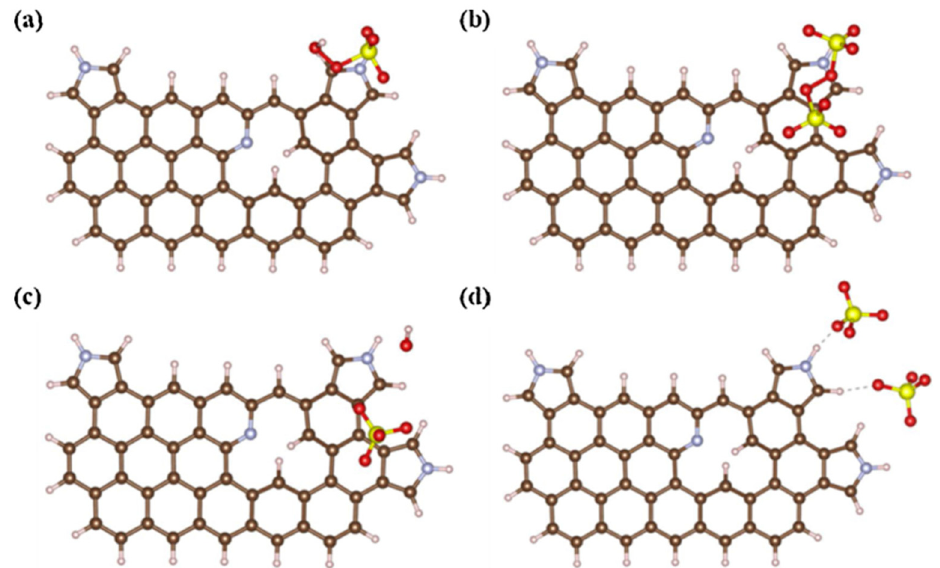
Figure 10. Adsorption of ( a ) PMS ( b ) PDS and the corresponding desorption of ( c ) PMS and ( d ) PDS on pyrrolic N [58], copyright 2021, Elsevier. on pyrrolic N [58], copyright 2021,